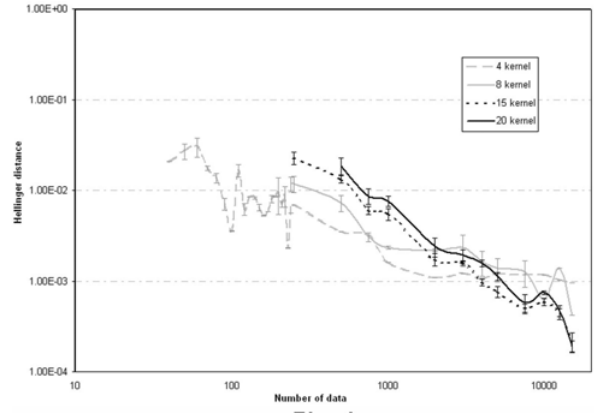
Fig. 9. Mean and standard deviation of the distance between the true PDF and its FGM estimation with varying number of data. The number of kernels is a